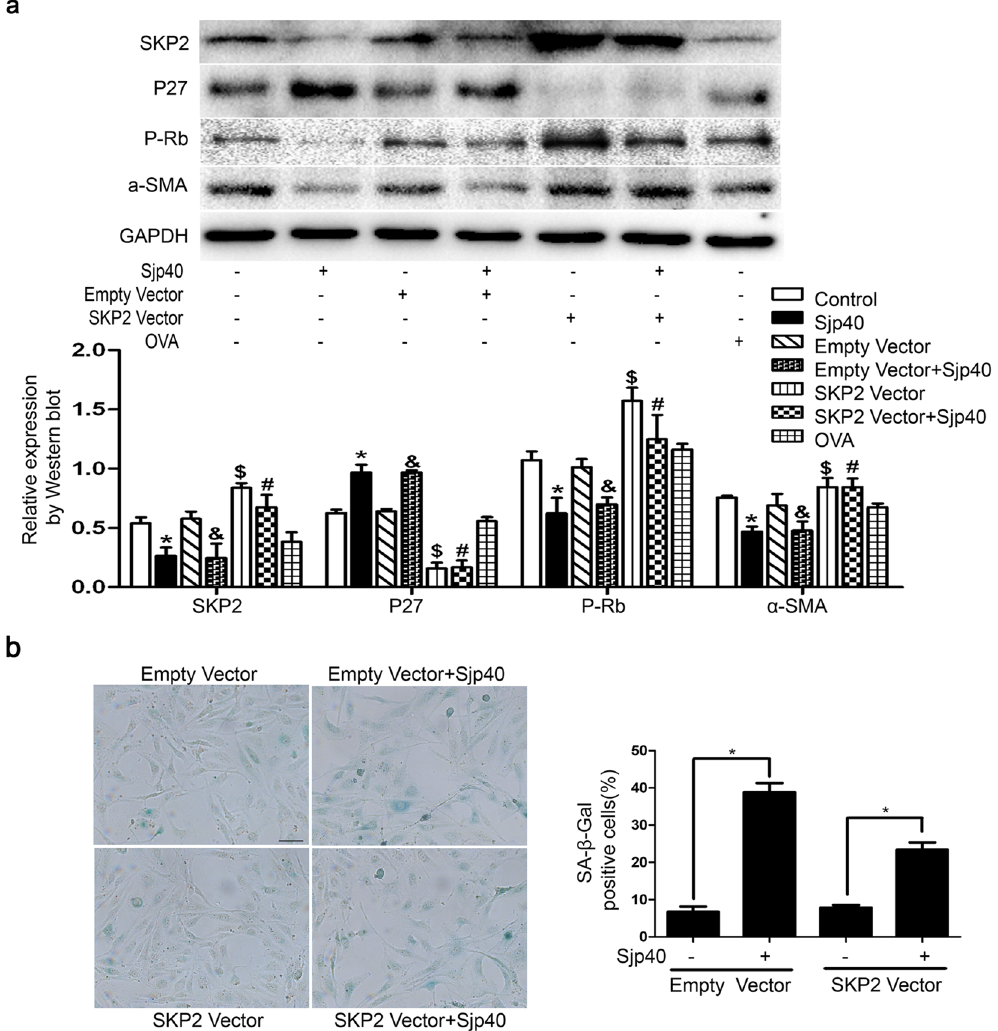
Figure 4. Enhanced expression of SKP2 by high expression plasmid restores Sjp40-induced senescence in LX-2 cells. ( a ) LX-2 cells were transfected with pcDNA3.1 or pcDNA-SKP2 and additionally treated with or without Sjp40 for 48 h. The protein levels of SKP2, P27, P-Rb and α -SMA were investigated by Western blot assay and date were expressed as the mean ± SEM of three or more independent trials. * p < 0.05 compared to the control group; & p < 0.05 compared to the pcDNA3.1 group. $ p < 0.05 compared to the control group; # p > 0.05 compared to SKP2-treated group. ( b ) Over-expression of SKP2 rescued the Sjp40-induced senescence analyzed by SA- β -Gal assay (original magnification 200 × ) and the graph also reveals quantitative analysis of the percentage of SA- β -Gal positive cells (%) expressed as the mean ± SEM of three or more independent trials. * p < 0.05 compared to the control group. Bar: 50